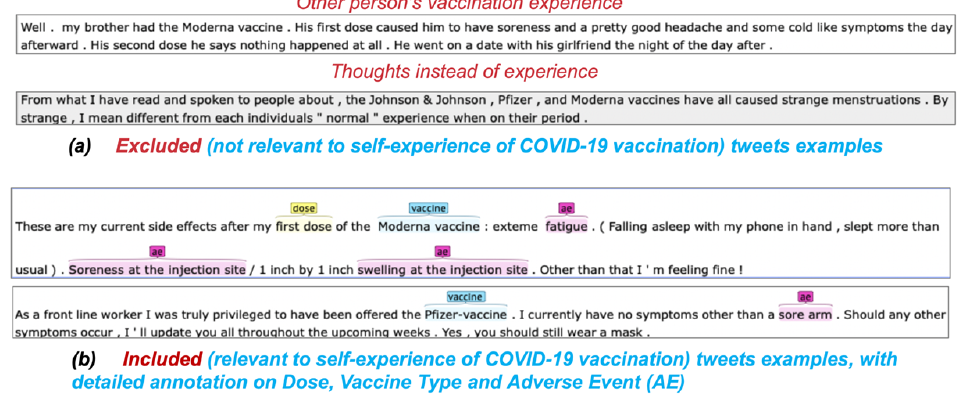
Table 1. Comparison of ML algorithms for tweet classification, implemented using the scikit-learn package.